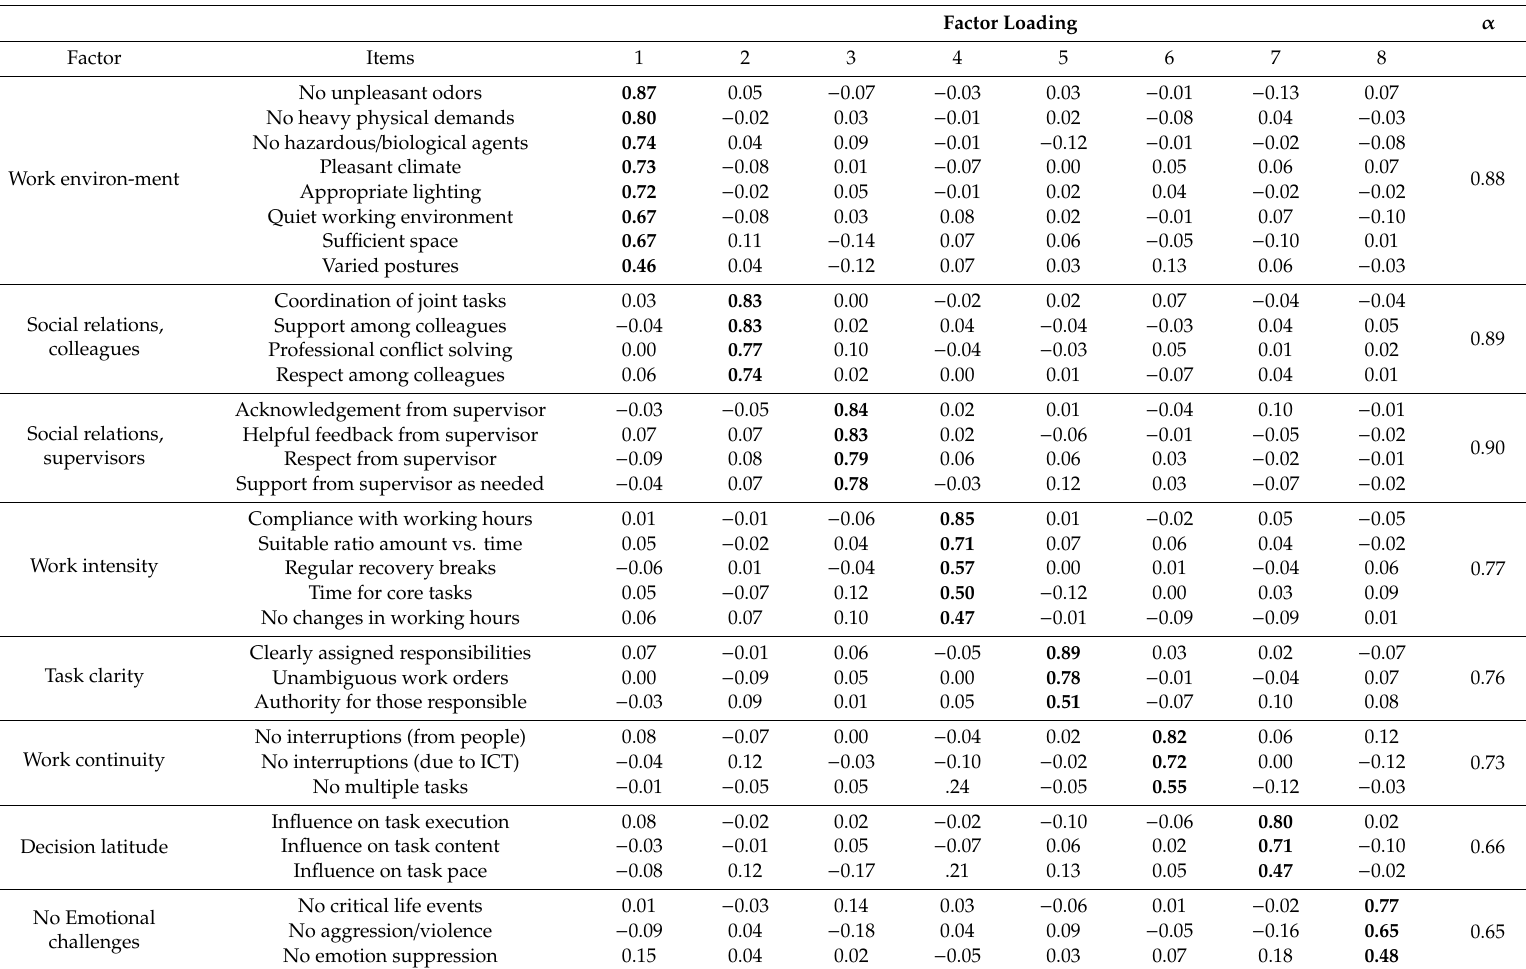
Table 1. Results of the Exploratory factor